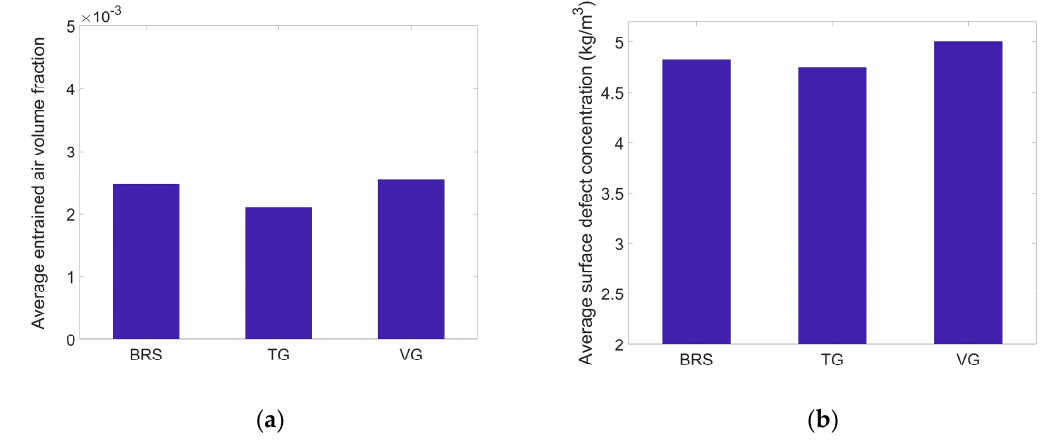
Figure 10. ( a ) Average entrained air volume fraction and ( b ) average surface defect concentration for the basic running system (BRS), trident gate (TG) and vortex gate (VG) designs.